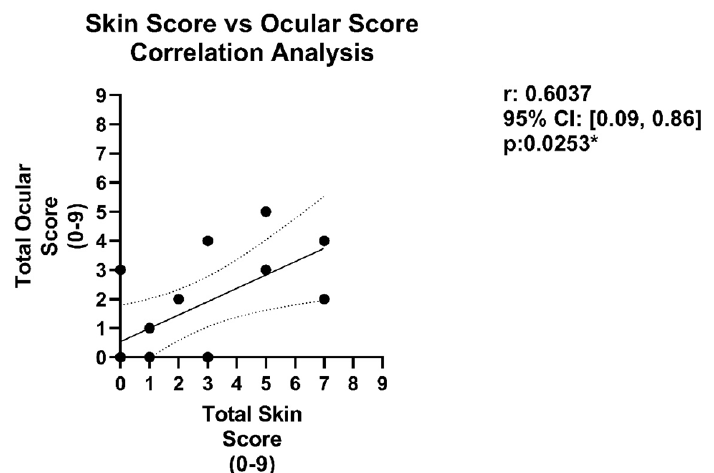
Figure 5. Correlation analysis comparing skin disease severity index with that of the ocular severity index at 8-weeks post-HSCT. Summary of results and comparisons of the skin disease variables and skin severity scores for the MHC-matched (B10.D2 → BALB/c), MHC-mismatched (B6 → B10.BR) GVHD models, and controls (bone marrow only). This included 4 mice from each GVHD model (n = 8 total) When the total ocular disease score index for each mouse was plotted against the total skin disease index, a significant correlation between skin and eye disease was identified: coefficient of 0.6037 ( p -value: 0.0253).